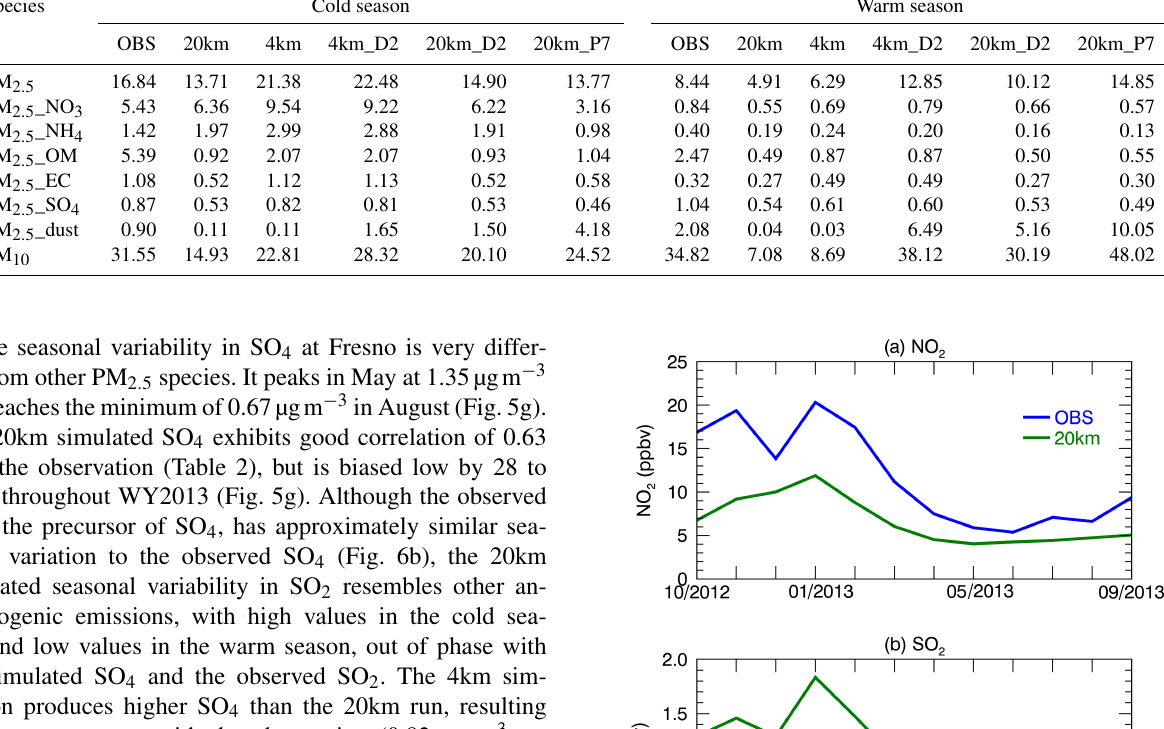
Table 3. Surface aerosol mass (µgm − 3 ) for different species at Fresno, CA. Species